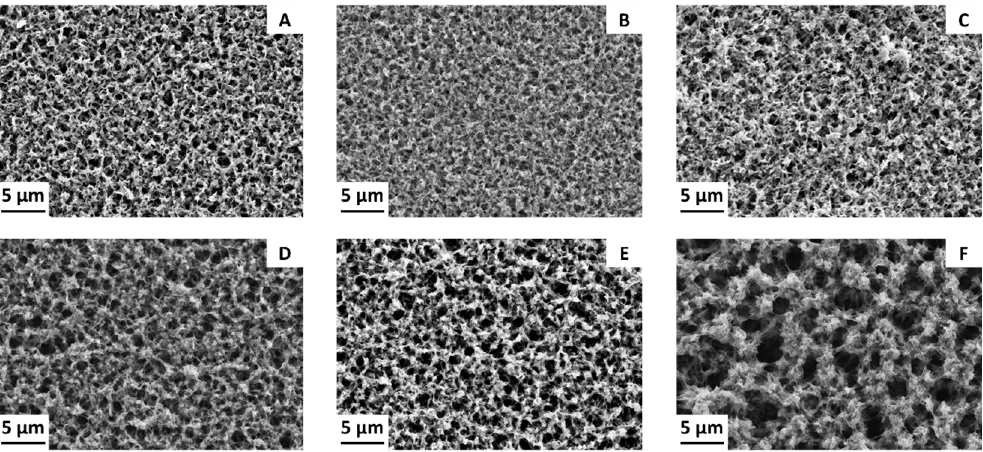
Figure 6. FE-SEM images of the surface of the 14.5 wt % PVDF membranes with ( A ) 0 wt % CB, ( B ) 0.5 wt % CB, ( C ) 1 wt % CB, ( D ) 2 wt % CB, ( E ) 5 wt % CB, and ( F ) 7.5 wt % CB.